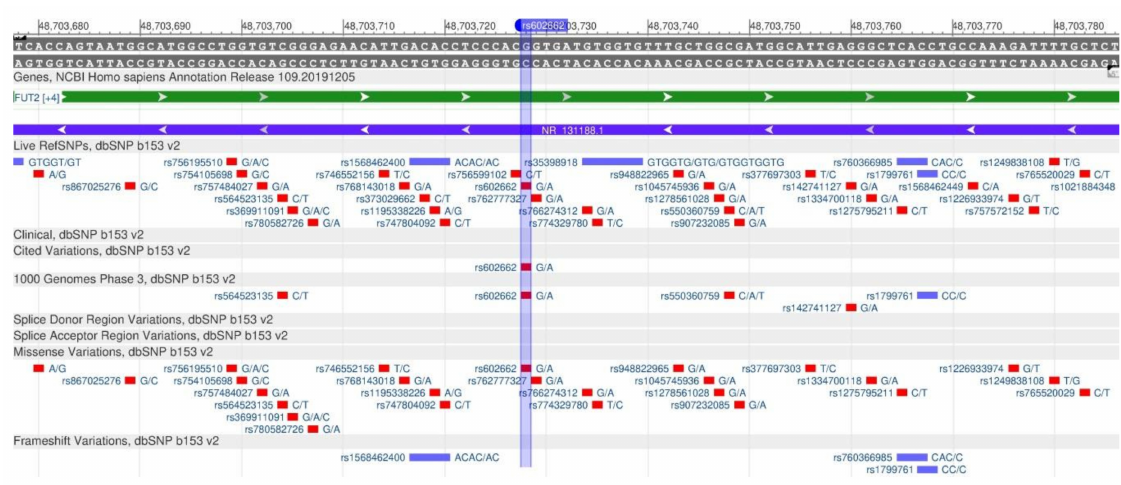
Figure 21. A portion of the FUT2 gene (located on the long (q) arm of chromosome 19) containing the oligonucleotide polymorphism rs602662.